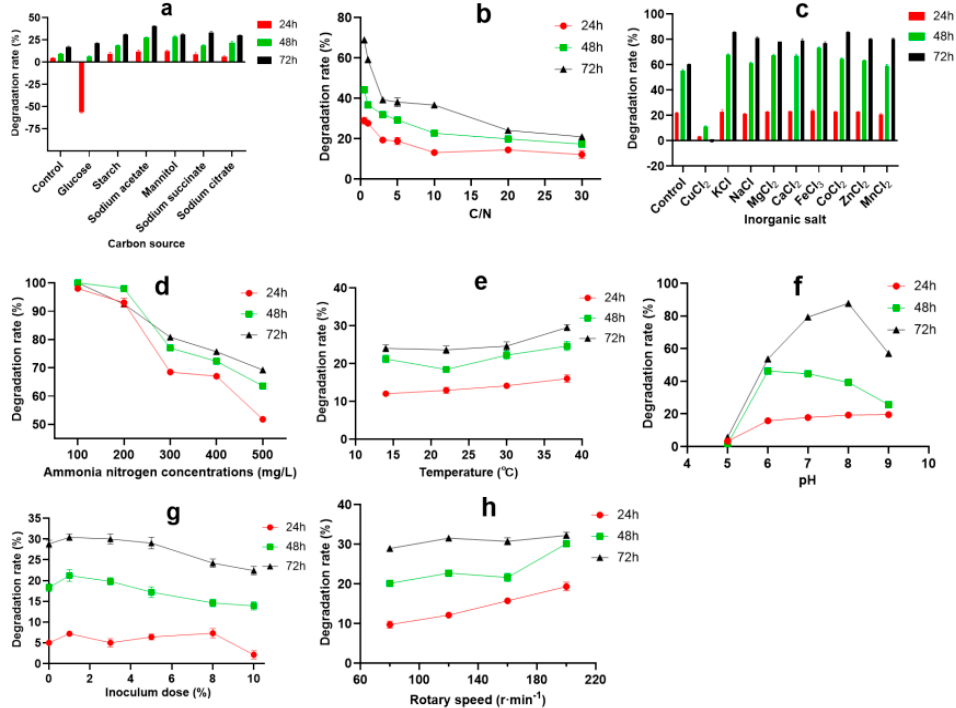
Figure 3. The effect of different additives in aquaculture wastewater on the degradation of ammonia nitrogen: ( a ) carbon source; ( b ) C/N; ( c ) inorganic salt; ( d ) initial concentrations of ammonia nitrogen; ( e ) temperature; ( f ) pH; ( g ) inoculum dose; ( h ) rotary speed.